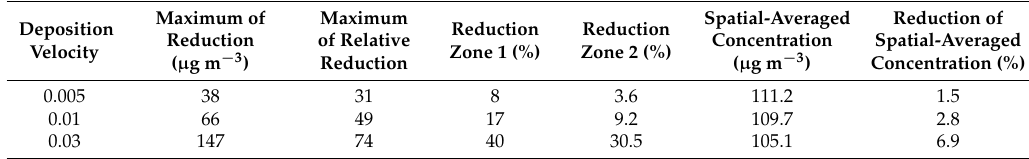
Table 4. Concentration reduction for vegetation with LAD = 0.5 m 2 m − 3 and 3 different deposition velocities (Current-2